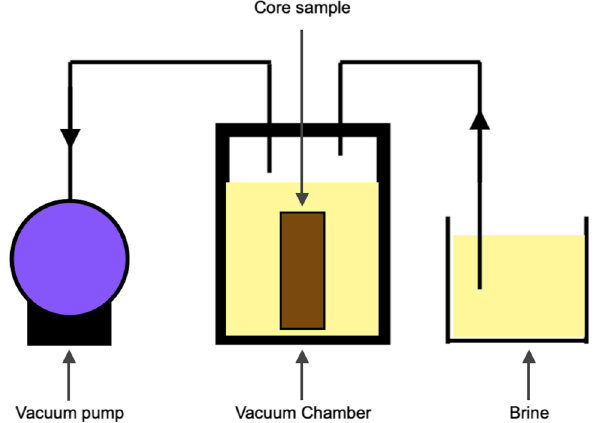
Fig. 3 Vacuum saturation set-up